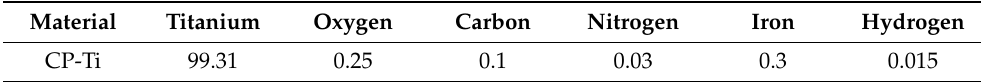
Table 3. Chemical composition of CP-Ti, % by weight.